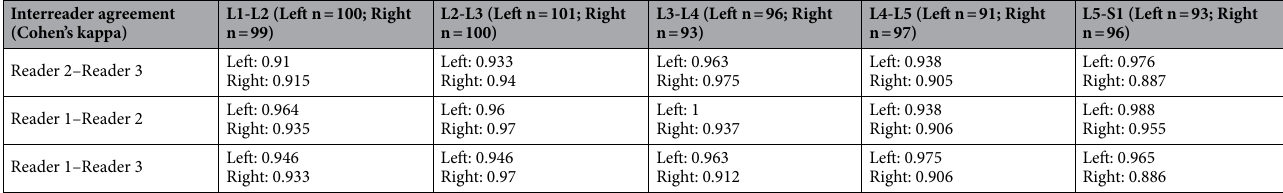
Table 1. Overview of interreader